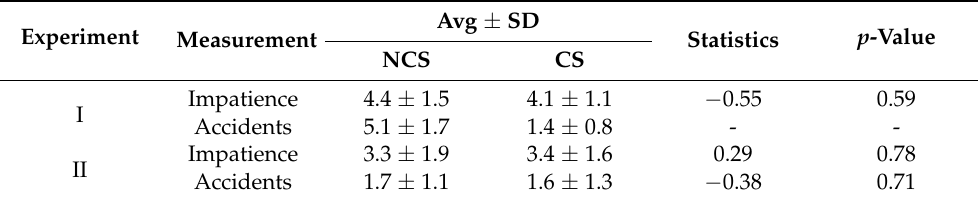
Table 6. Subjective impatience and number of accidents in CS and NCS groups in Experiment I and